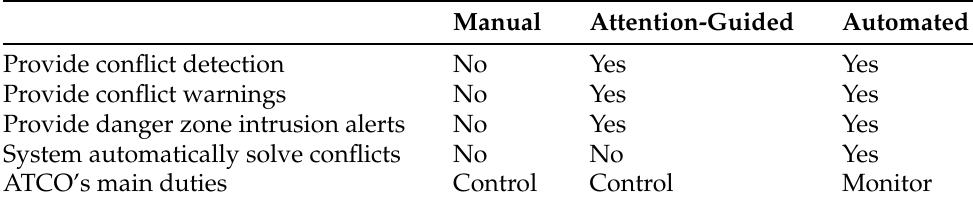
Table 1. Comparison of three